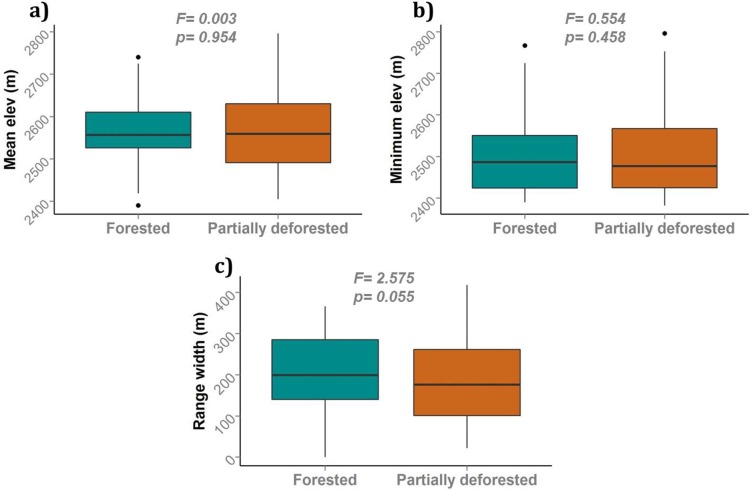
Comparison of elevational range variables for forested and partially deforested transects (p values shown are for one-factor ANOVAs).a) Abundance-weighted mean elevation. b) Minimum elevation. c) Elevational range width. Dots represent outliers.